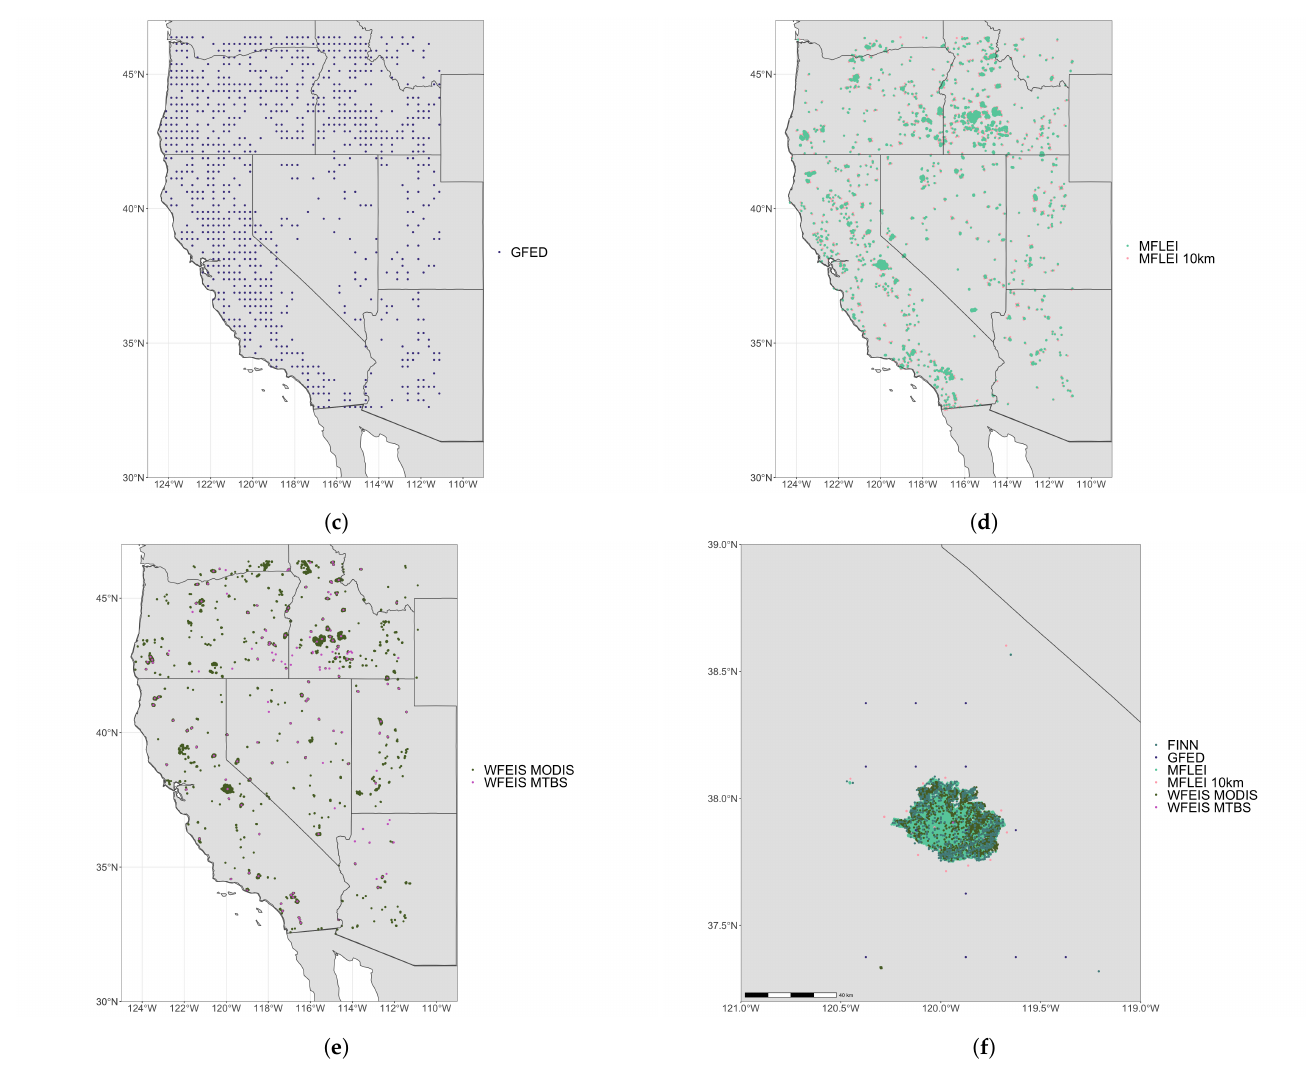
Figure 1. ( a ) All Inventories ( b ) FINN ( c ) GFED ( d ) MFLEI (250 m) + MFLEI (10 km) ( e ) WFEIS (MODIS) + WFEIS (MTBS) ( f ) Yosemite Rim Fire. Maps showing the burned area pixels reported by each fire emissions inventory. These maps show the difference in fire location between each inventory due to inventory resolution and